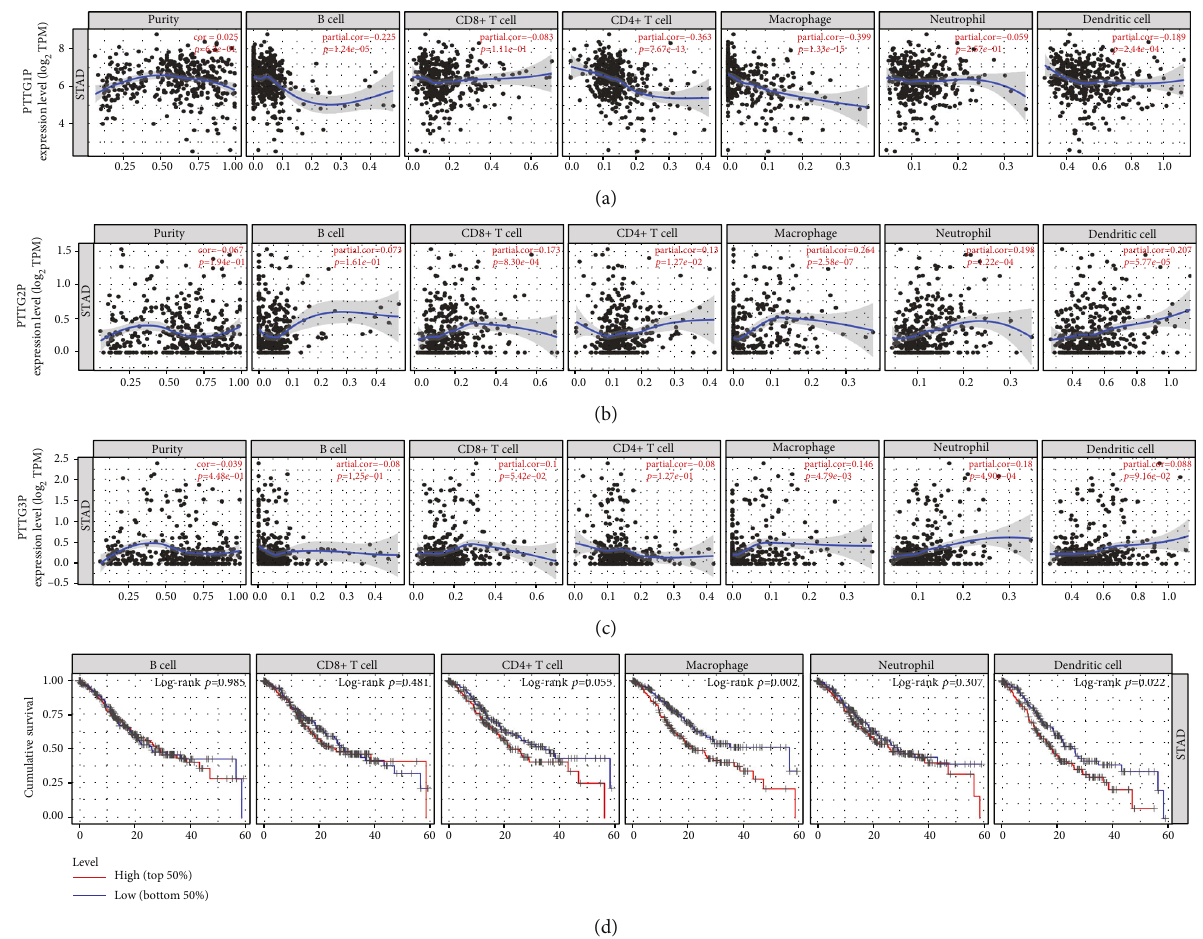
Figure 6: Immune in fi ltrates are linked to PTTG expression in gastric cancer (TIMER). (a – c) Immune cell in fi ltration is associated with the expression of PTTGs (PTTG1, PTTG2, and PTTG3P) in patients with STAD. Pearson ’ s correlation was used for the analysis of the correlation. Immune cell in fi ltration ’ s prognostic relevance in gastric cancer